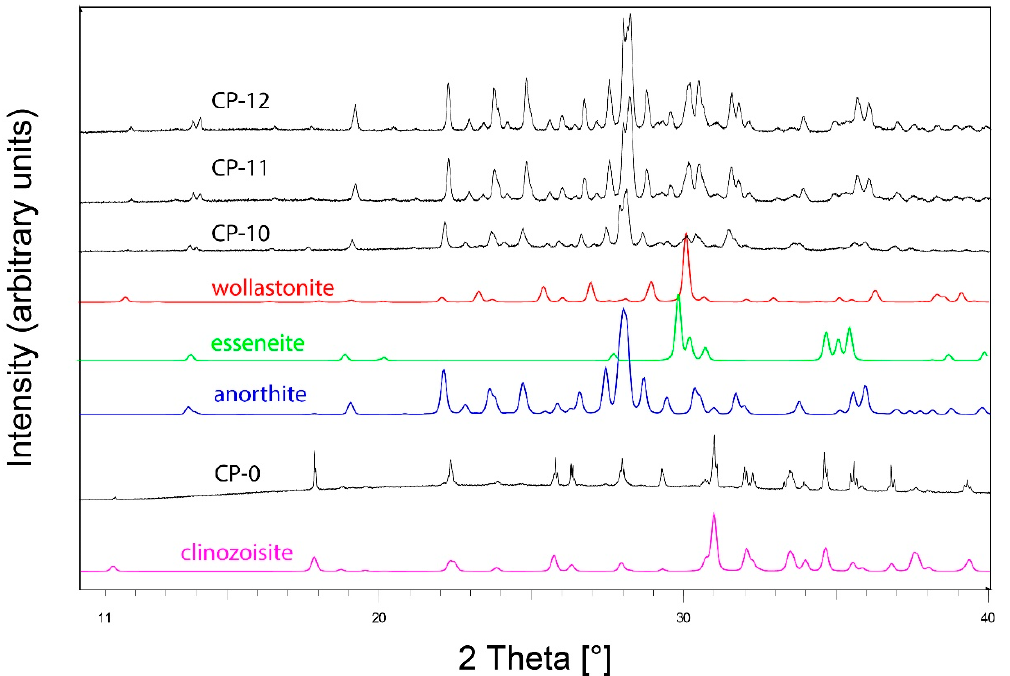
Figure 5. Powder X-ray diffraction patterns of clinozoisite experimental samples (CP) compared to patterns of wollastonite [39], anorthite [40], esseneite [33], and clinozoisite [14] (modeled from structural data using pseudo-Voigt function).